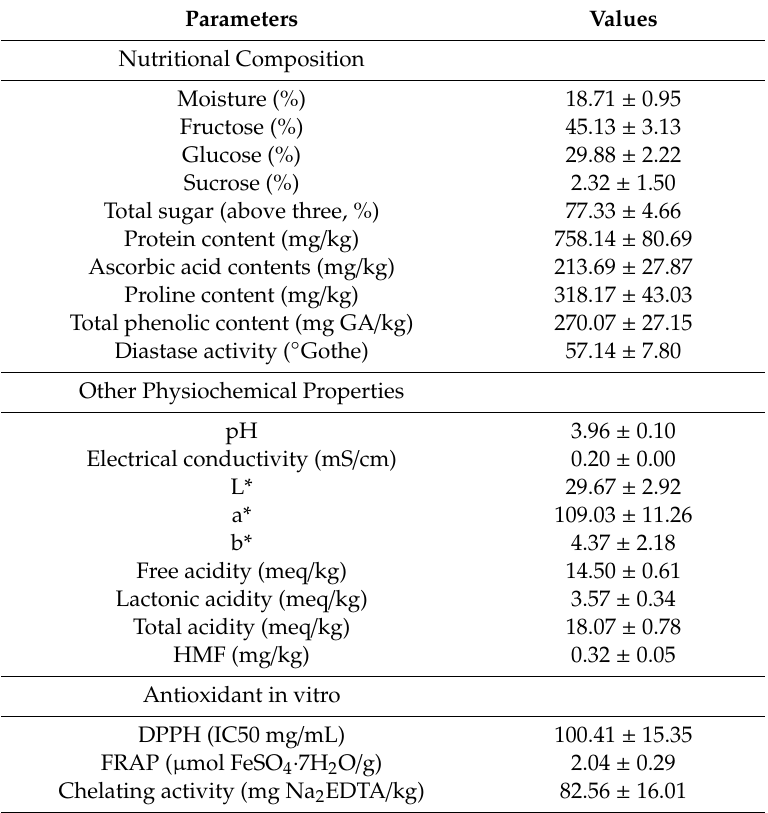
Table 3. Results of physicochemical and bioactive analysis of honey